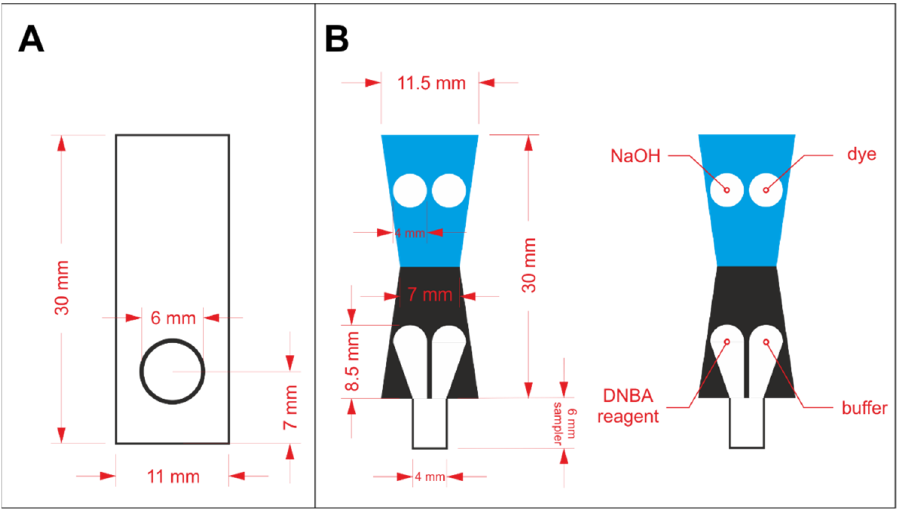
Figure 1. The design of wax barriers for: ( A ) protein assay optimization and ( B ) protein to creatinine ratio